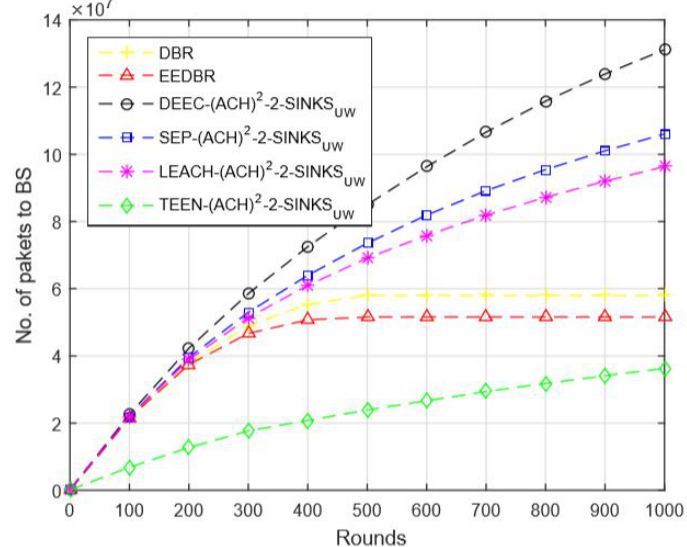
Figure 15. Number of Packets Sent to